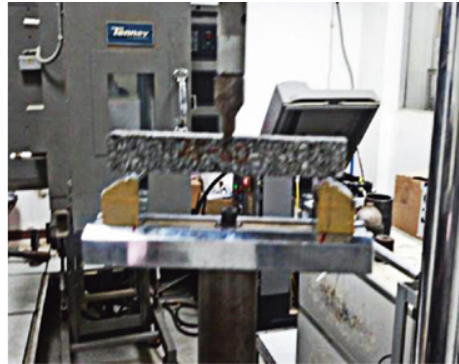
Figure 4. Impact-toughness